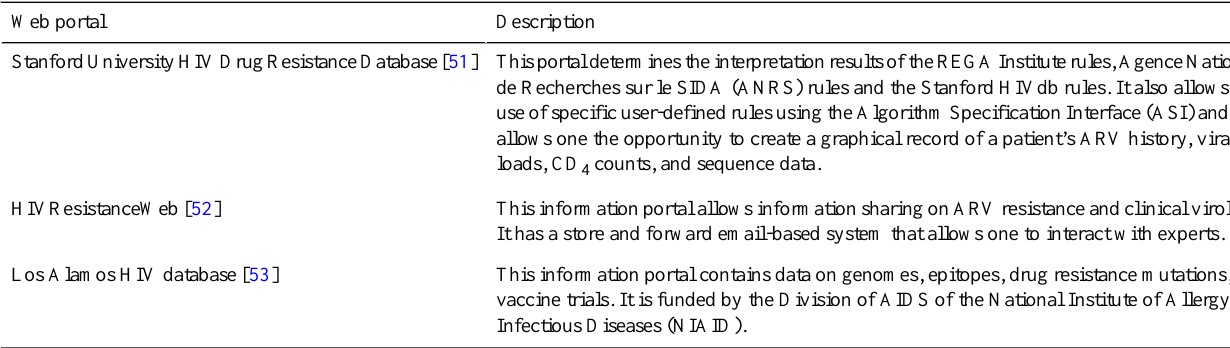
Table 7. Descriptions of Web portals for managing HIV treatment